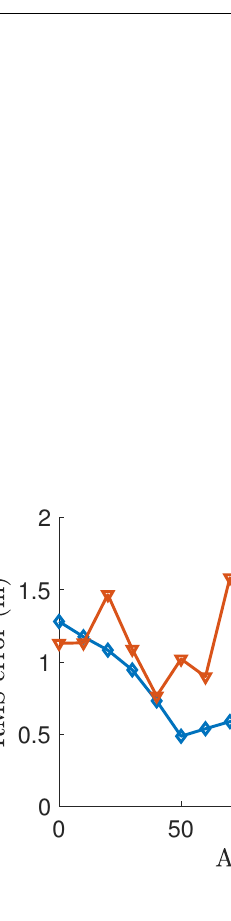
Figure 5. ( a ) Average RMS error at different receiver tilt angle. ( b ) CDF analysis on the impact of receivers and angular